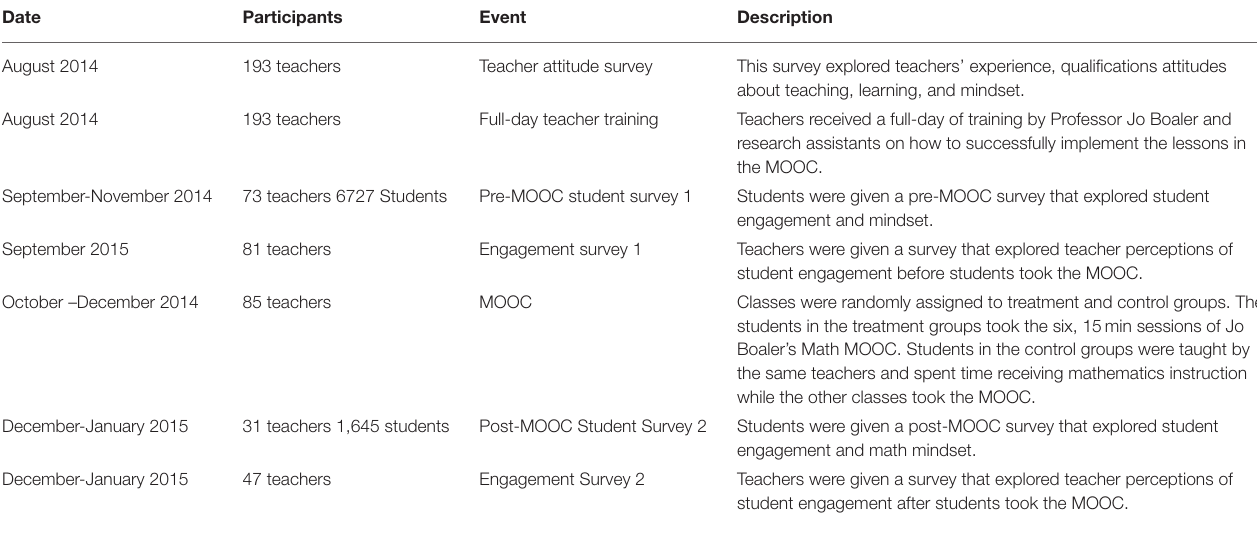
TABLE 3 | Project timeline.